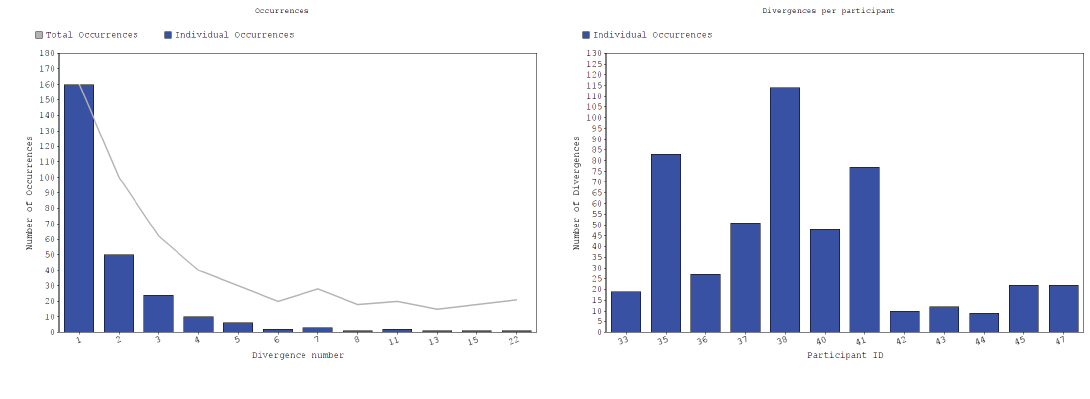
Figure 5. Occurrences of individual divergences ( left ) and occurrences of divergences per participant ( right ), when considering both pedestrian and vehicular